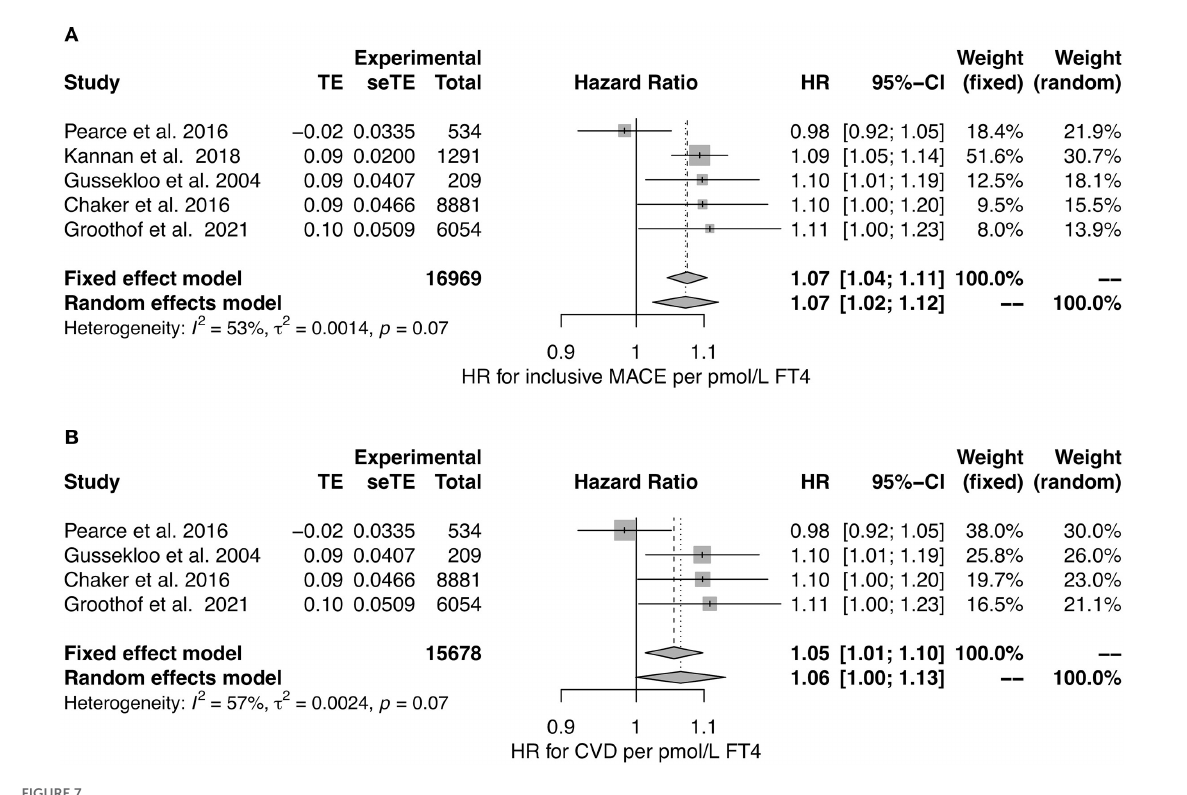
FIGURE7 HR for MACE (A) and CVD (B) in relation to FT4 concentration (36, 39, 120, 129, 131).